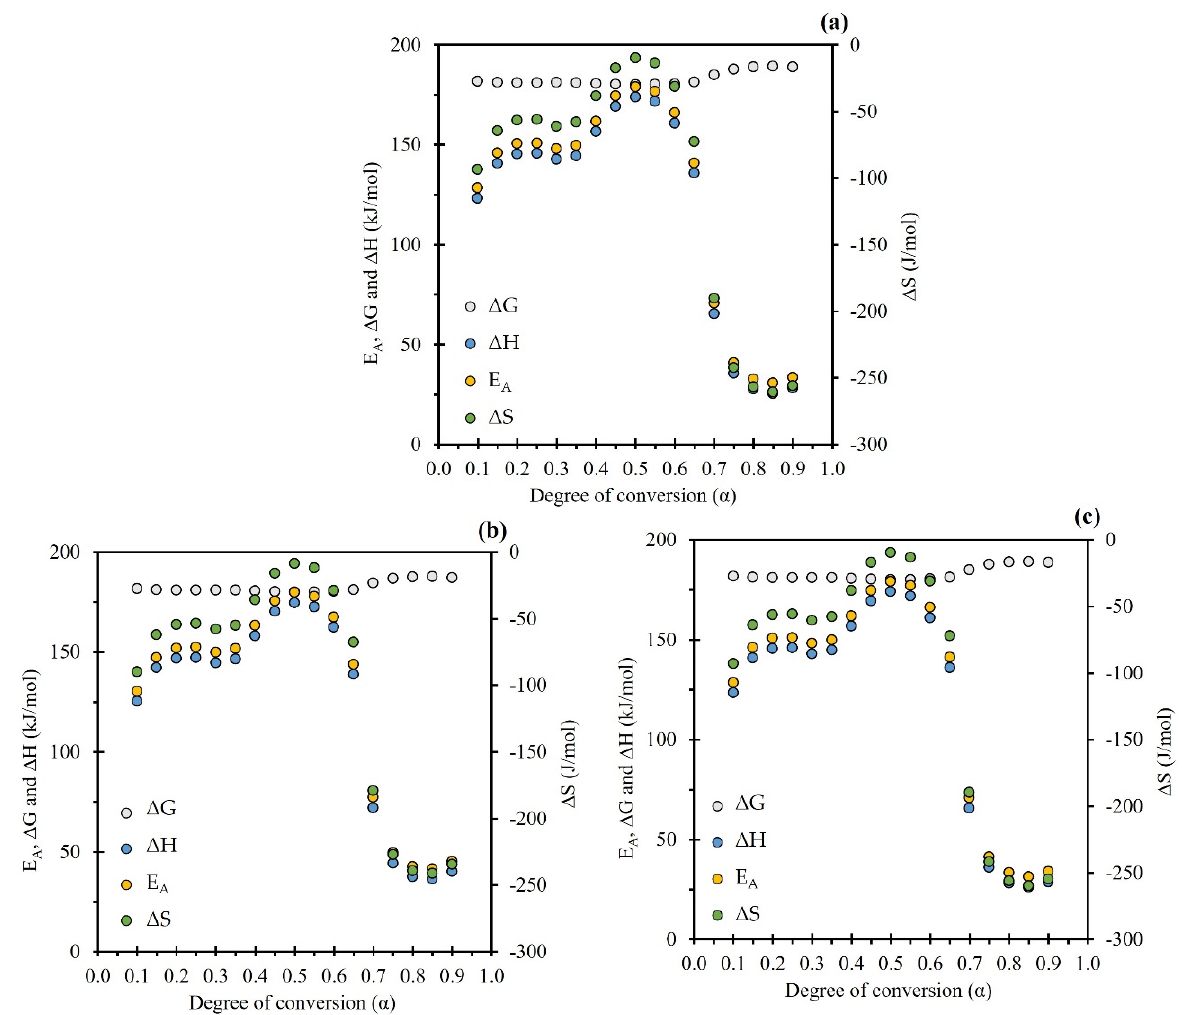
Figure 6. Thermodynamic parameters from the ( a ) KAS, ( b ) FWO, and ( c ) Starink methods.